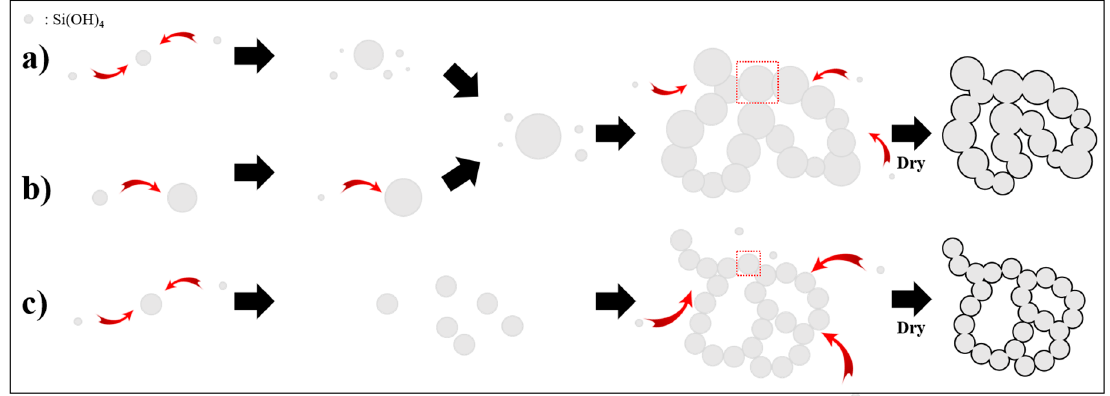
Figure 5. Schematic representation of particle growth and gelation at ( a ) slow, ( b ) fast, and ( c ) optimized acidic feeding rate.